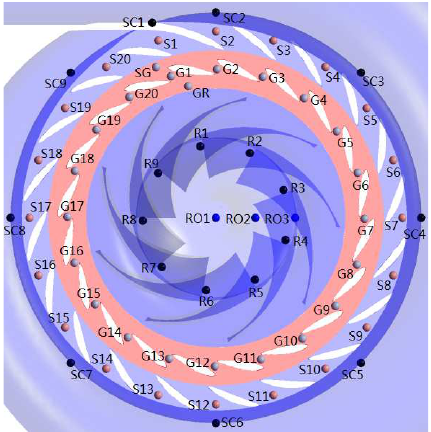
Figure 6. ( a ) Locations of monitoring points on the blade; ( b ) locations of monitoring points on the guide vane; and ( c ) locations of monitoring points in the draft tube domain.